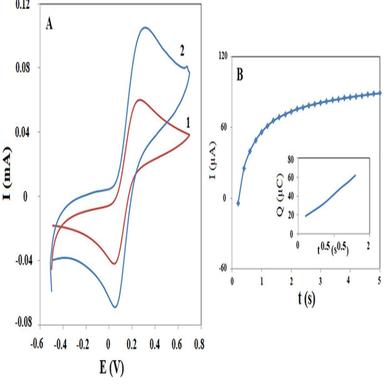
(A) The Cyclic voltammograms of bare CPE (1) and GO-imi- (CH2)2-NH2 modified CPE (2), (B) Plot of I-t curves of GO-imi- (CH2)2-NH2 modified CPE in 0.005 M k3Fe (CN), Insert:plots of Q-t0.5 curves of bare GO-imi- (CH2)2-NH2 modified CPE in 0.005 M k3Fe(CN)3.